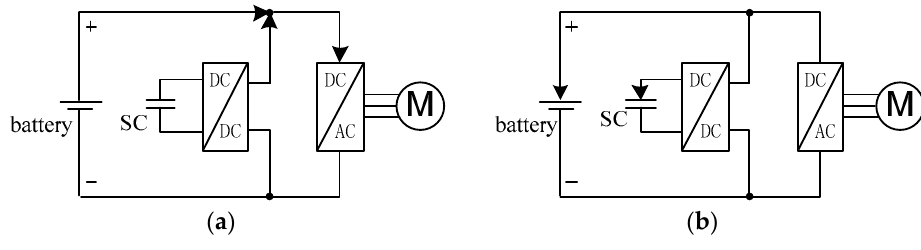
Figure 2. The different modes of operation of semi-active topology: ( a ) power flow based on driving mode; and ( b ) power flow based on braking mode.